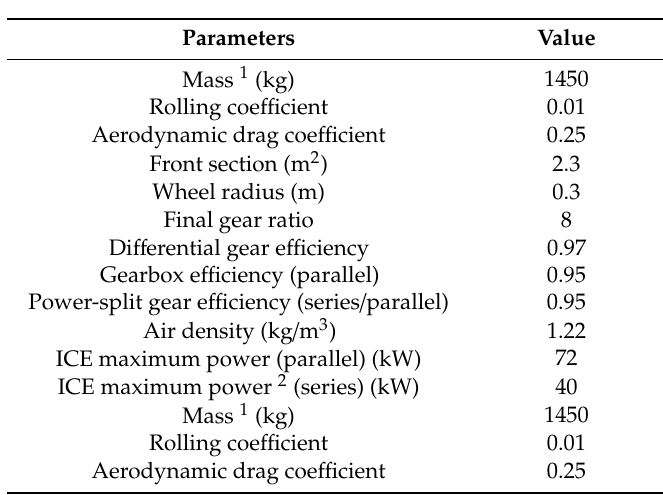
Figure 12. The 40-kW diesel ( a ) and 40-kW diesel + TC ( b ) efficiency contour map. ICE working point in series architecture are shown. Table 5. Vehicle longitudinal parameters.